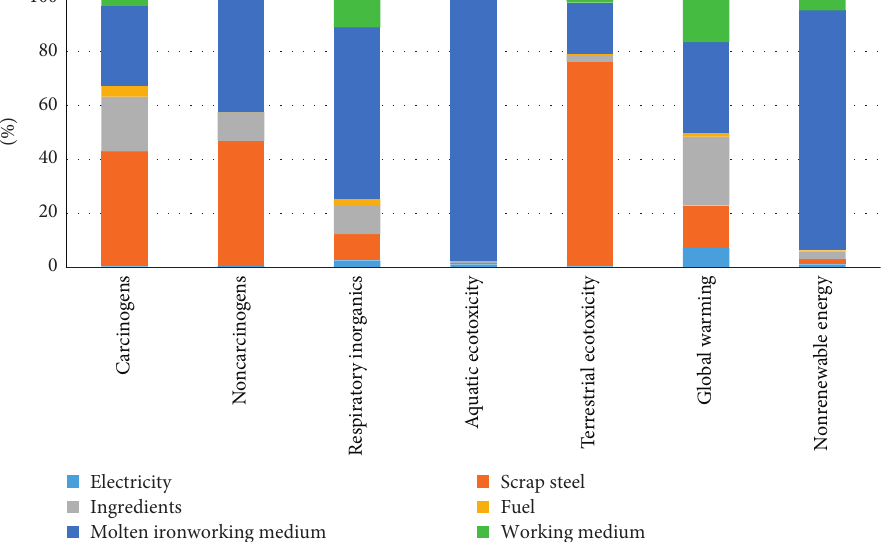
Figure 4: Main process that contribute to significantly affected categories.